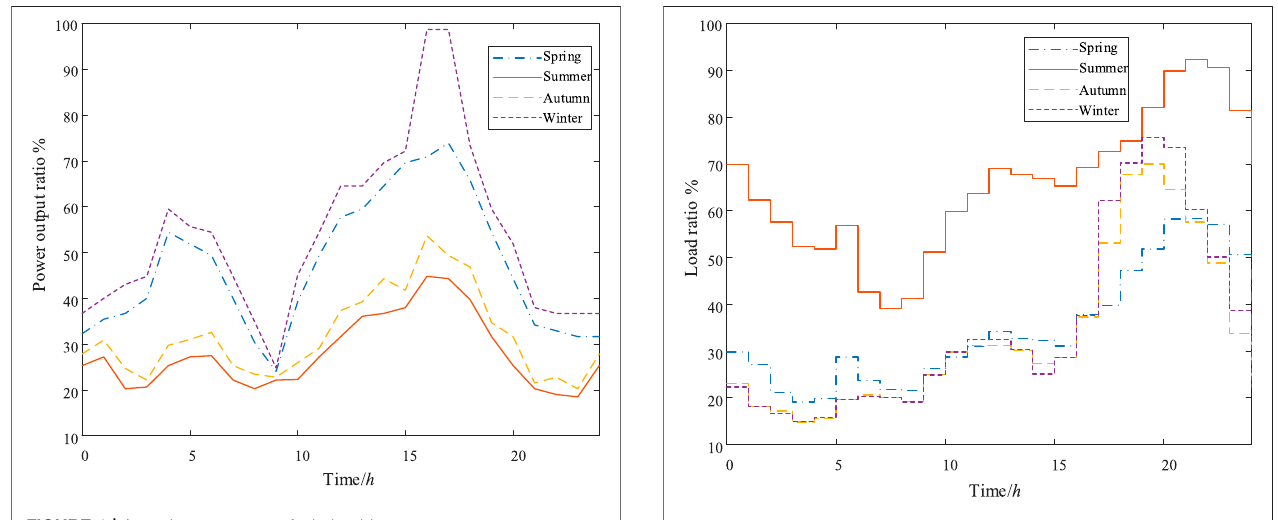
FIGURE 1 | Annual output curve of wind turbine.